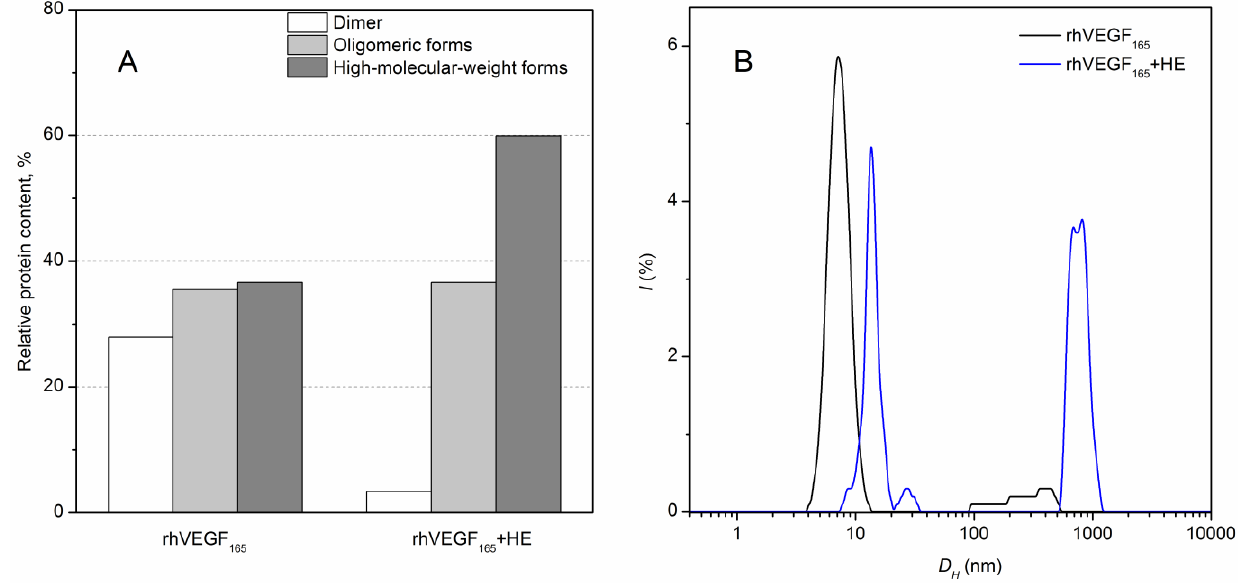
Figure 2. HE-dependent changes in quaternary structure of rhVEGF 165 (10 mM Na-phosphate, 50 mM NaCl, pH 7.4). ( A ) Effects of HE (25 µM) on distribution of rhVEGF 165 (25 μM) multimeric forms at 37 °C, as judged from glutaraldehyde crosslinking experiments at 37 °C; ( B ) DLS data on size distribution (hydrodynamic diameter D h ) of rhVEGF 165 (10 µM) in solutions in the absence (black line) and presence of 11 µM HE (blue line) at 25 °C.